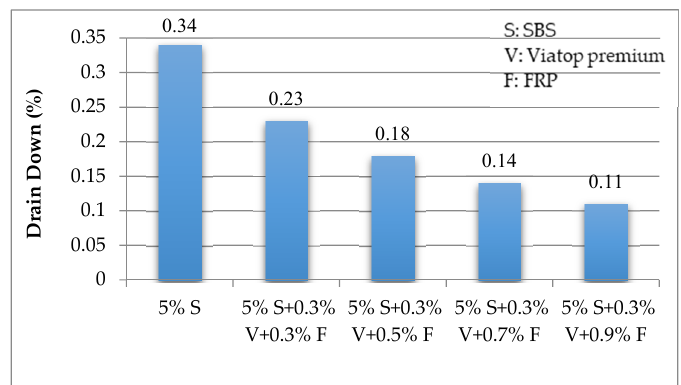
Figure 6. Results of Drain down test.